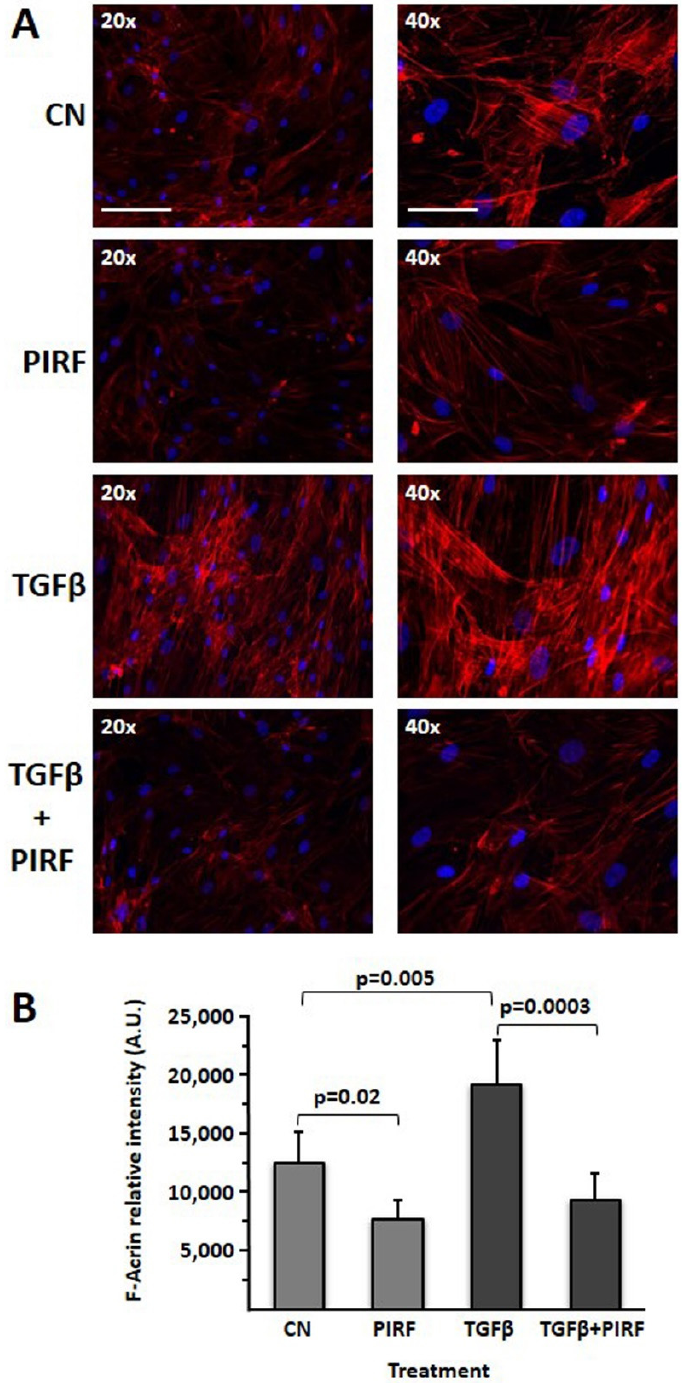
Figure 9. Evaluation of the expression of F-actin in SCI13D cells treated or untreated with TGF β or TGF β + Pirfenidone ( A ) Pirfenidone (PIRF) consistently reduced F-actin fiber fluorescence in SCI13D fibroblasts treated at basal conditions as well as stimulated with TGF β . ( B ) Determination of F-actin relative intensity. Histograms are the average ± SD of six different images acquired in duplicate wells for each treatment after 72 h.; scale bars = 12.5 μ m and 6.25 μ m for the left and right columns, respectively.